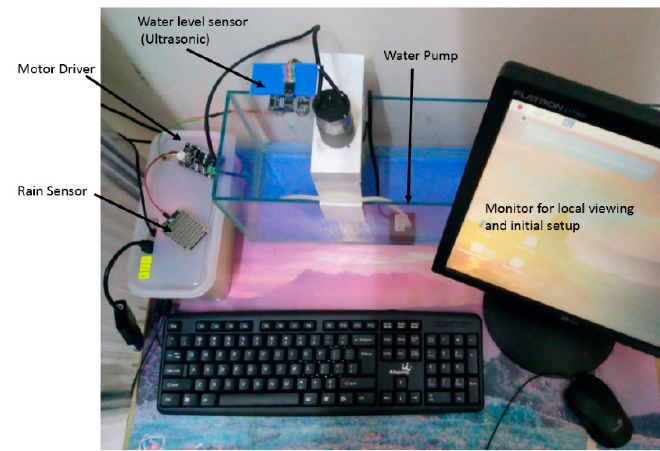
Figure 5. Gate V1 hardware components.